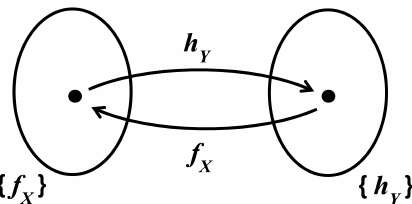
Figure 1. Venn diagram of the Siamese twin functions f X and h Y . The left oval together with the black point inside it is a Venn diagram representing the singleton black point inside it is a Venn diagram representing the singleton the mapping of f X to h Y by h Y , the lower arrow the mapping of h Y to f X by f X